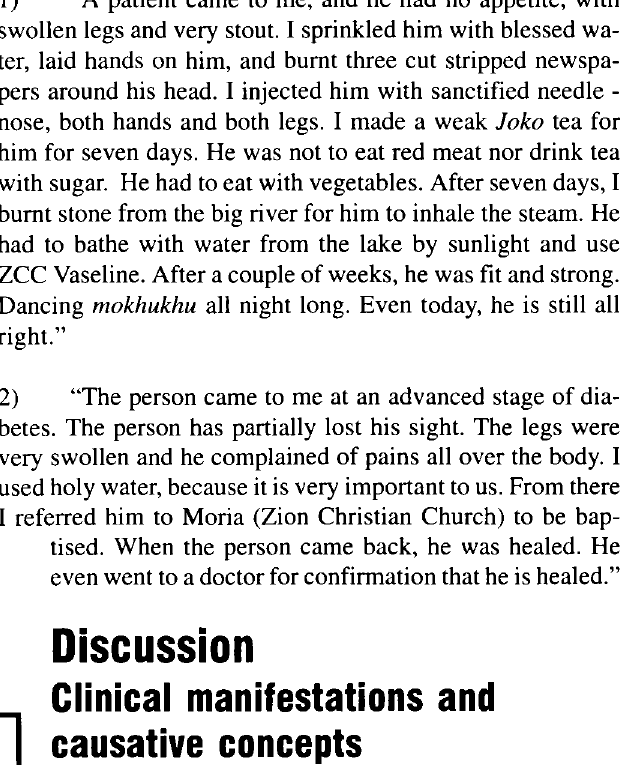
Table 4 : Help-seeking of diabetic patients prior to consulting the traditional healer (TH) and faith healer (FH) by